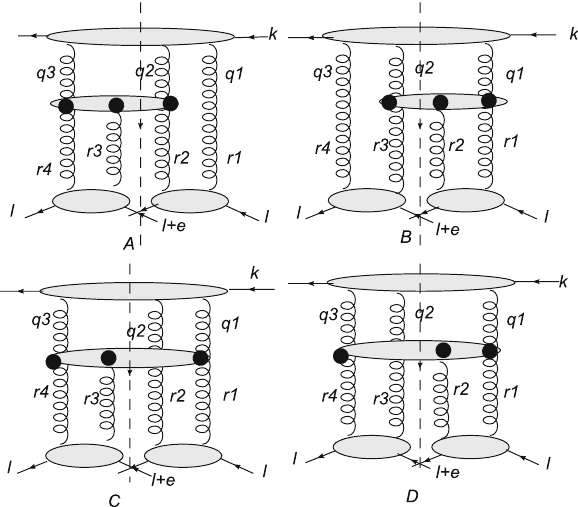
Fig. 6 The diffractive amplitudes with three reggeons attached to the projectile